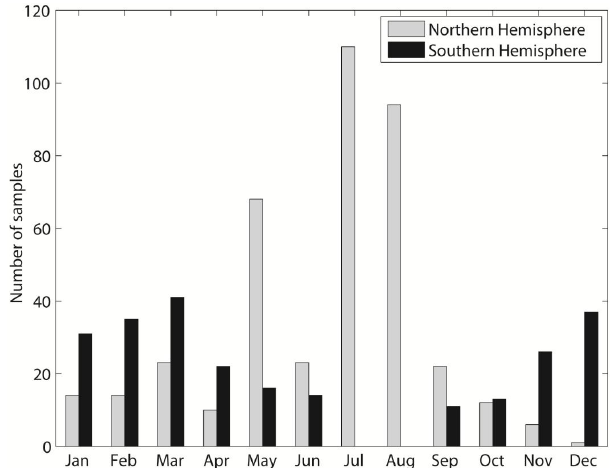
Figure 5. Number of samples collected in each month, separated into Northern Hemisphere and Southern Fig. 5: Number of samples collected in each month, separated into Northern and Southern 259 hemisphere. 260